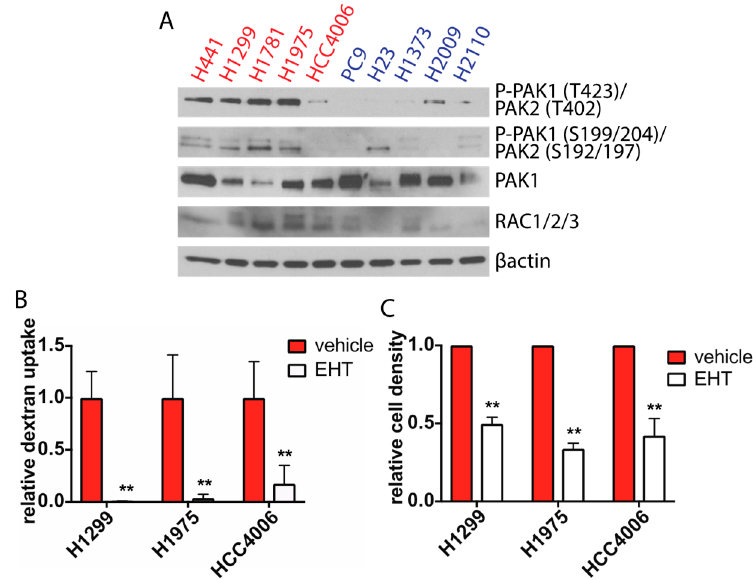
Figure 3. Rac signaling is increased in glucose independent cells and Rac inhibition decreases macropinocytosis and glucose-free growth. ( A ) Immunoblot analysis of Rac signaling activity via Pak autophosphorylation at Ser 199/204 (Pak1)/Ser192/197 (Pak2) and Thr-423 (Pak1)/Thr402 (Pak2). Glucose independent (red) and glucose addicted (blue) cells were cultured in GFM for 6 h before lysate collection. ( B ) Quantification of the levels of FITC-dextran uptake in glucose starved glucose independent cells treated with either vehicle or 5 µ m EHT 1864 (EHT) 1 h prior to incubation with FITC-dextran. Data is normalized to vehicle treated cells, error bars indicate ± SD of 10 fields scored containing at least 10 cells. ( C ) Relative density of glucose starved cells treated with vehicle or 5 µ m EHT 1864 for 48 h as determined by crystal violet staining. Data is normalized to density of vehicle treated cells at 48 h; error bars indicate ± SEM of three independent experiments. Significance was calculated using Student’s t -test, ** p < 0.005.